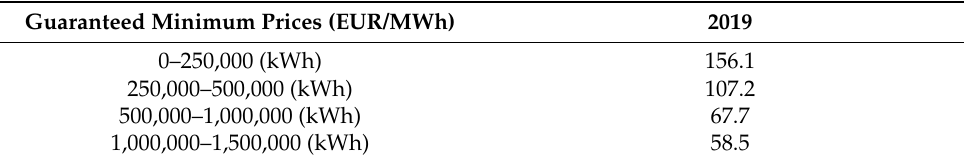
Table 3. Minimum guaranteed prices in 2019